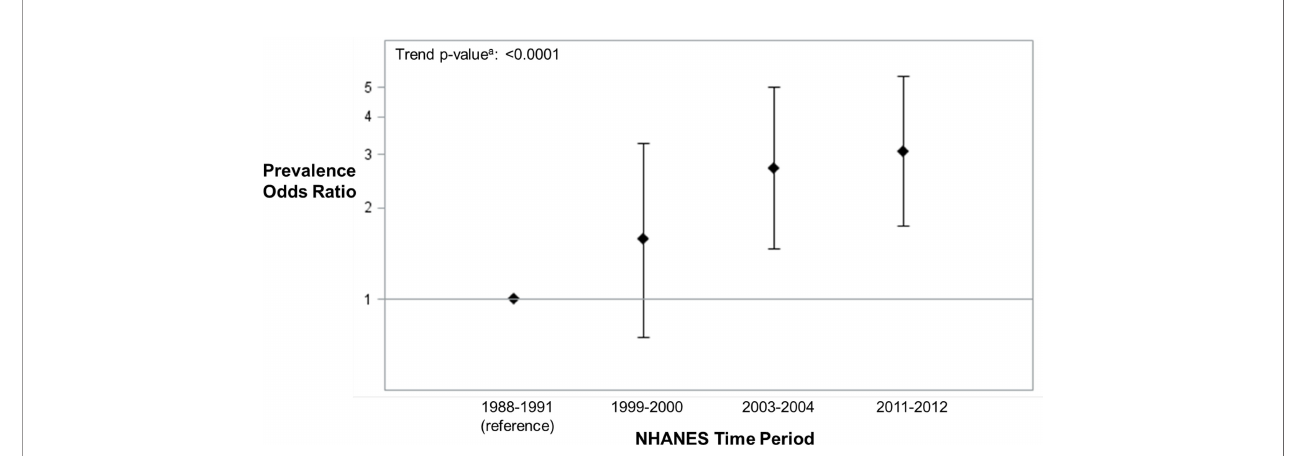
FIGURE 3 | ANA Prevalence Odds Ratios (95% Con fi dence Intervals) in U.S. Adolescents by NHANES Time Period (n=2594) adjusted for age, sex, race/ethnicity, BMI and education of reference parent. a The ANA time trend assessments were based on two logistic regression models that adjusted for the survey design variables (strata, clusters, and sampling weights) and categorical covariates. One model added a categorical covariate for time period and estimated the ANA prevalence odds ratio for each period, relative to the fi rst. The other model added a quantitative covariate for the number of years between period midpoints, relative to the fi rst, and produced a P-value from a c 2 -test to assess an ANA time